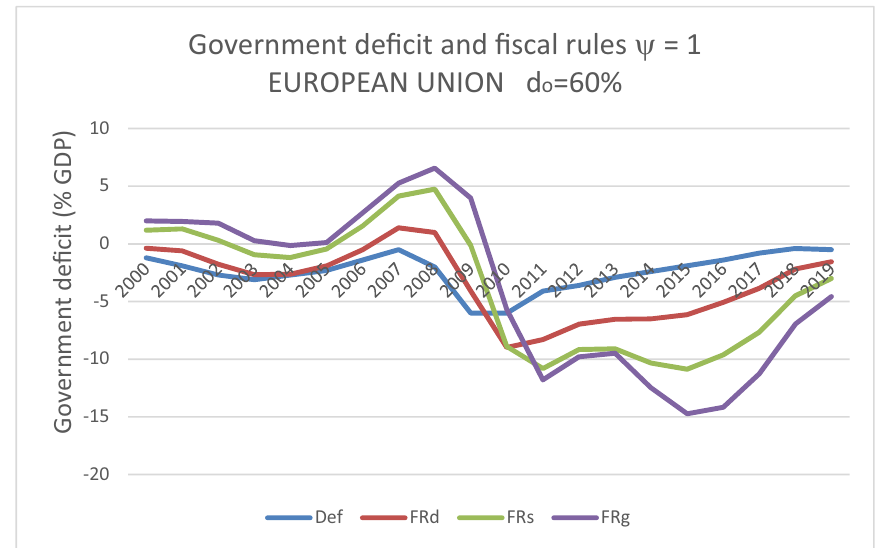
Figure 1.1: EU - 27 countries government de fi cit ψ = 1 ( Source: Own elaboration from data on Table 1 ) .